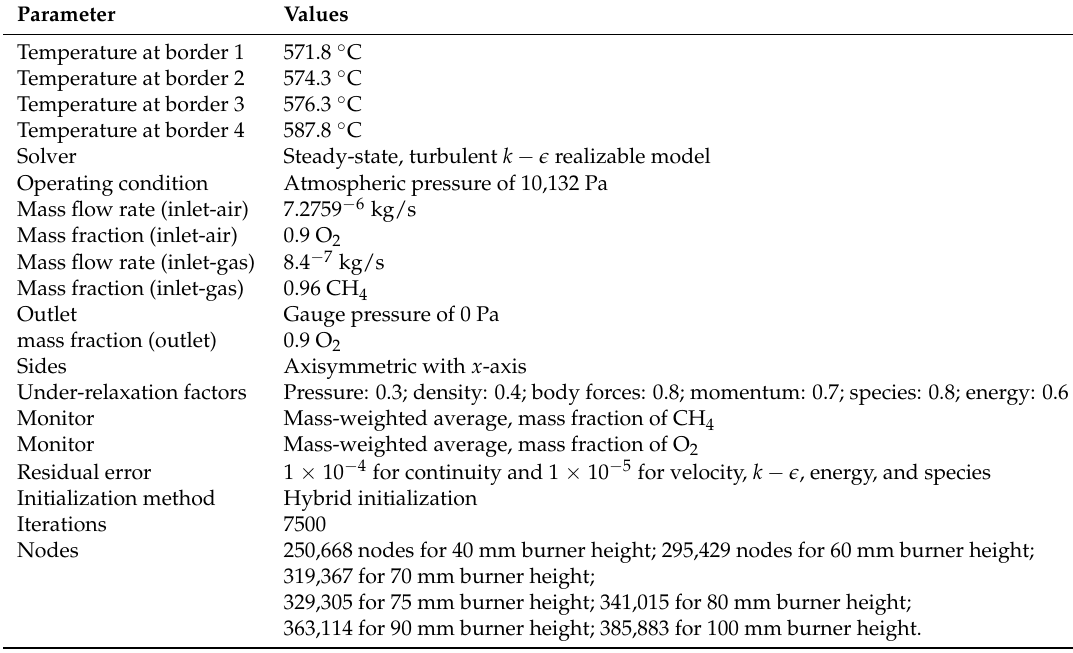
Table 2. Parameter and values for the simulations performed.